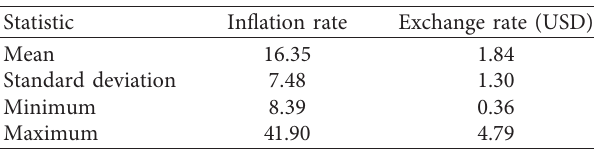
Table 2: Descriptives.